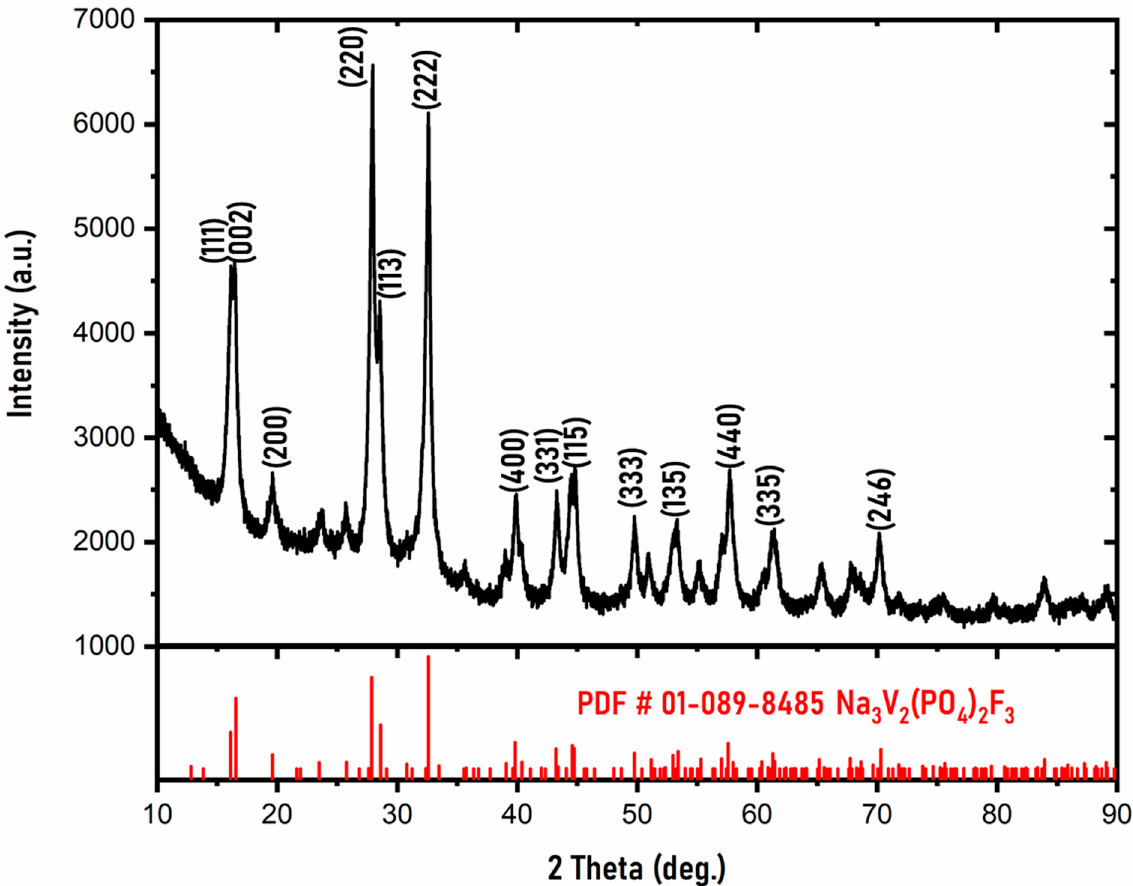
Figure 1. XRD spectra of the synthesized phase-pure NVPF material. Table 1. The lattice parameter values and cell volume of the synthesized and reference NVPF.